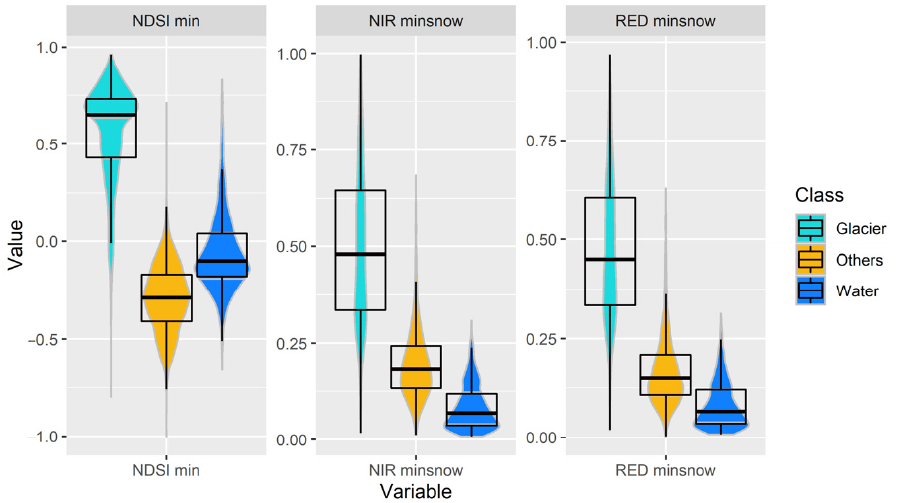
Figure 3. Example of a violin box plot diagram for the Landsat TM and ETM+ sensors in 2000.